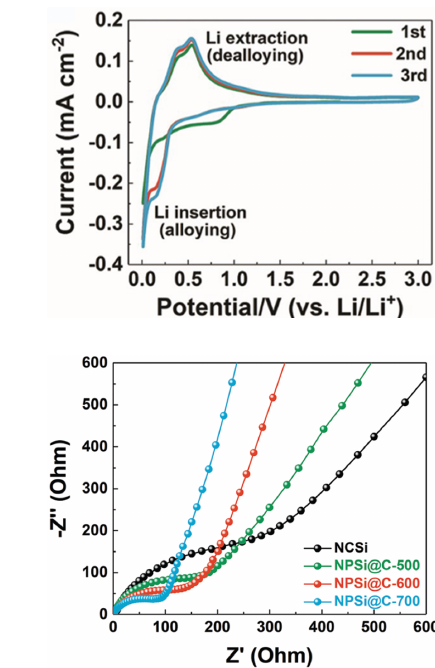
Figure 22. ( Top left ) Charge/discharge curves and ( Top right ) cyclic voltammetry curves, ( Bottom left ) rate capability, and ( Bottom right ) Nyquist plots for distinct NP-Si@C anodes with different etching temperatures. Reproduced with permission [107].